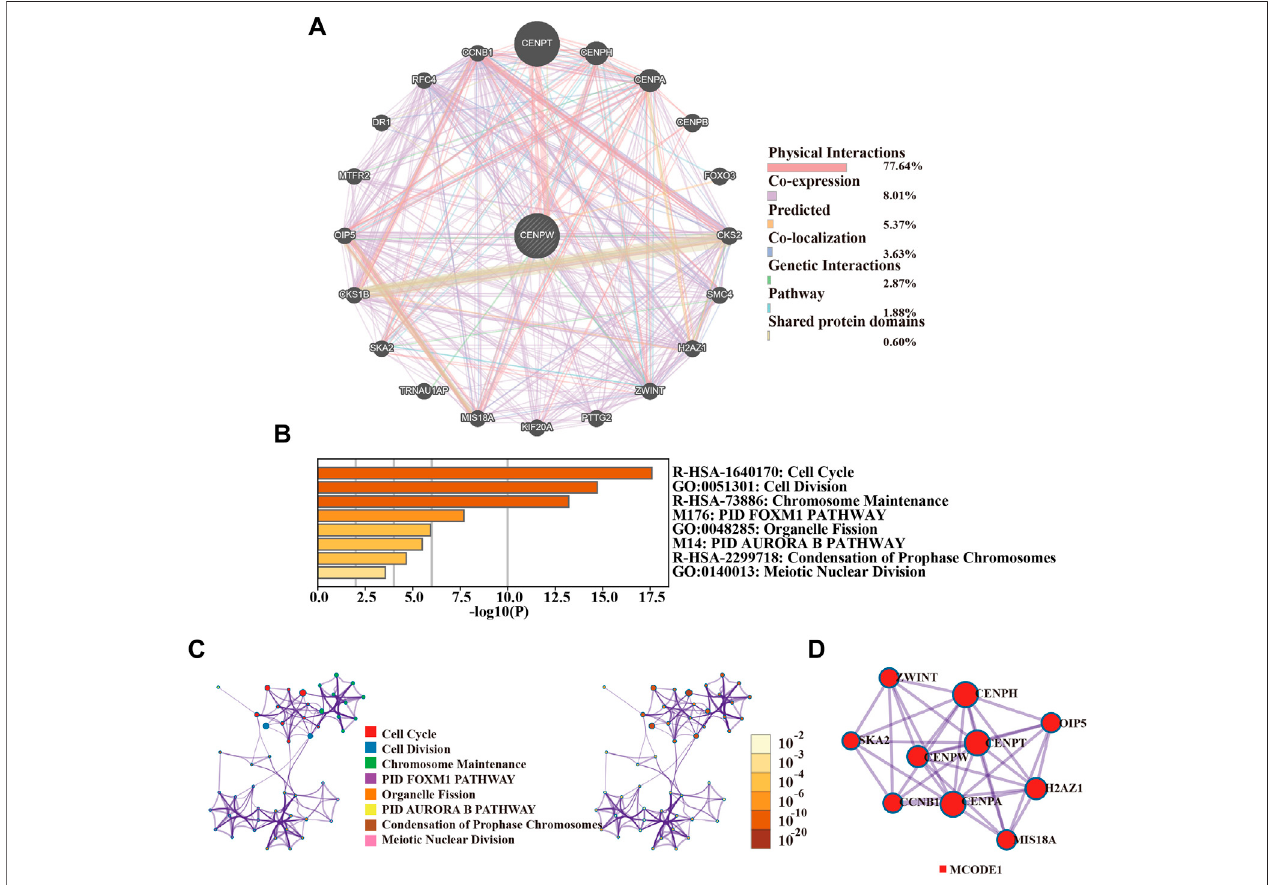
FIGURE 7 | The enrichment and interaction of CENPW related genes. (A) PPI network of CENPW from the Metascape database. (B) Functional enrichment and signal path of the overlapping genes. (C) The GO and KEGG analysis suggesting the distribution and relation of the diverse functions according to Metascape Online database. (D) PPI network and MCODE showed associated genes interacting with CENPW